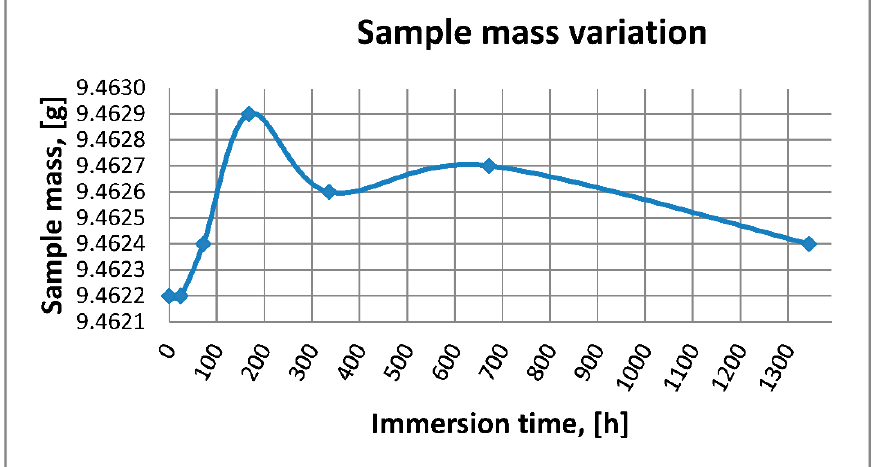
Figure 3. 3D-printed CoCrMo metallic implants mass vs. immersion time variation.